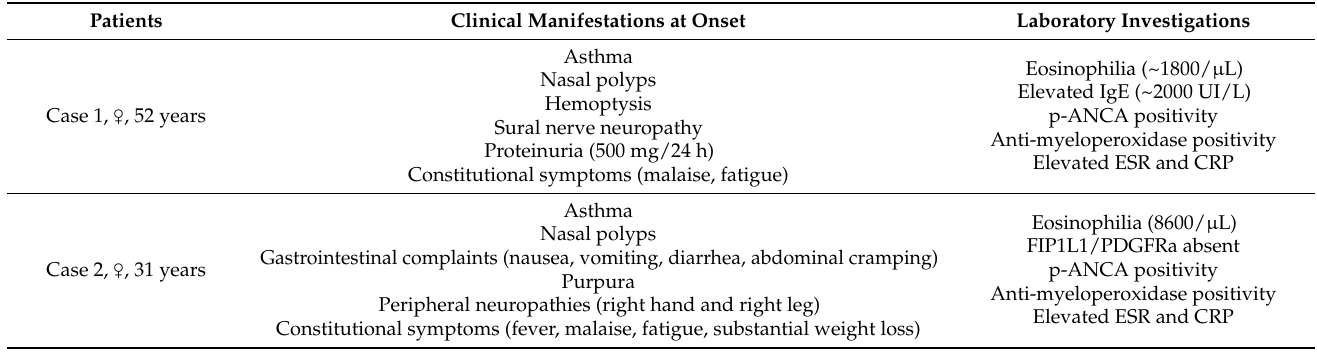
Table 2. Characteristics of the patients administered IL-5-targeted